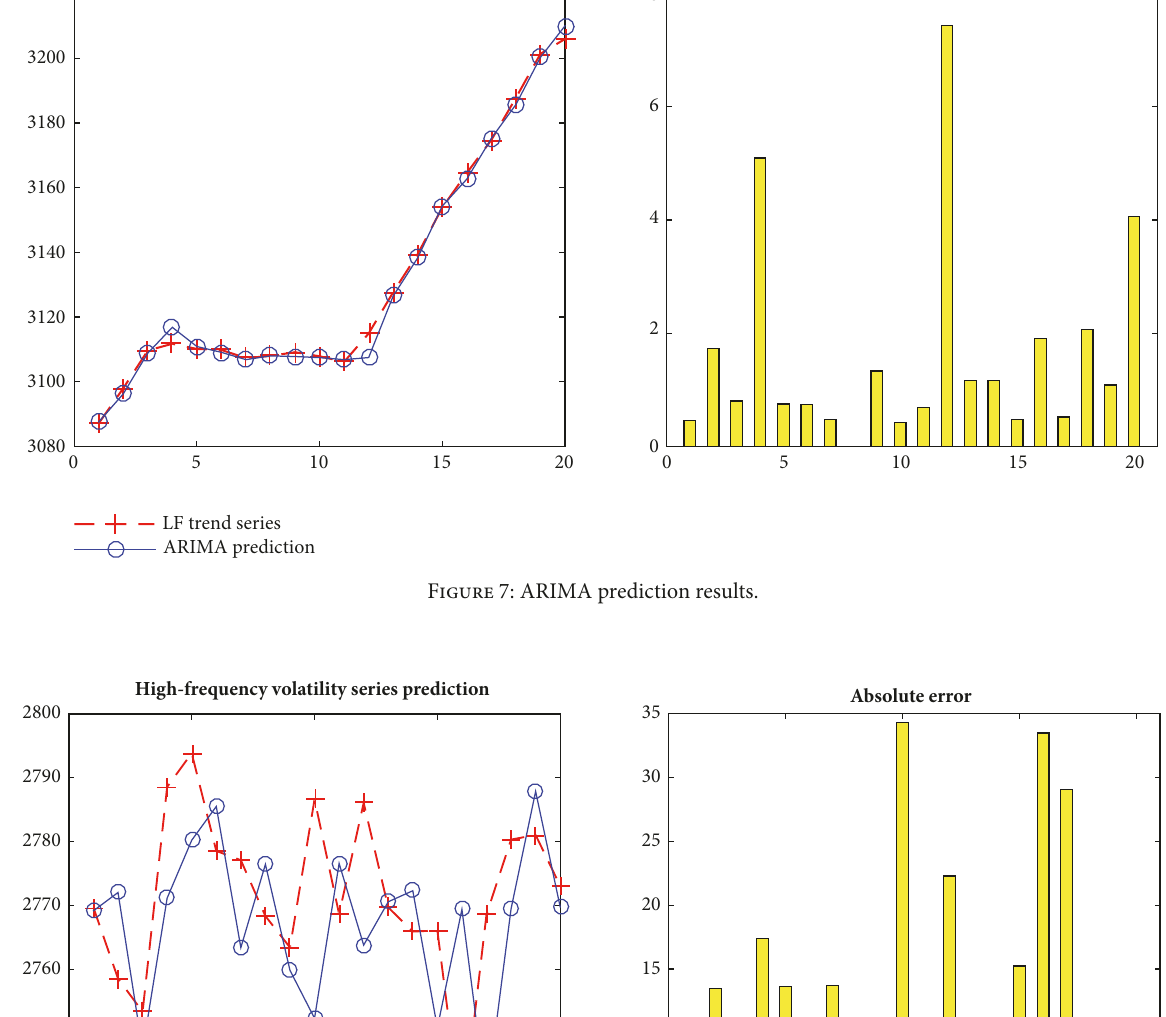
Figure 8: BP neural network prediction